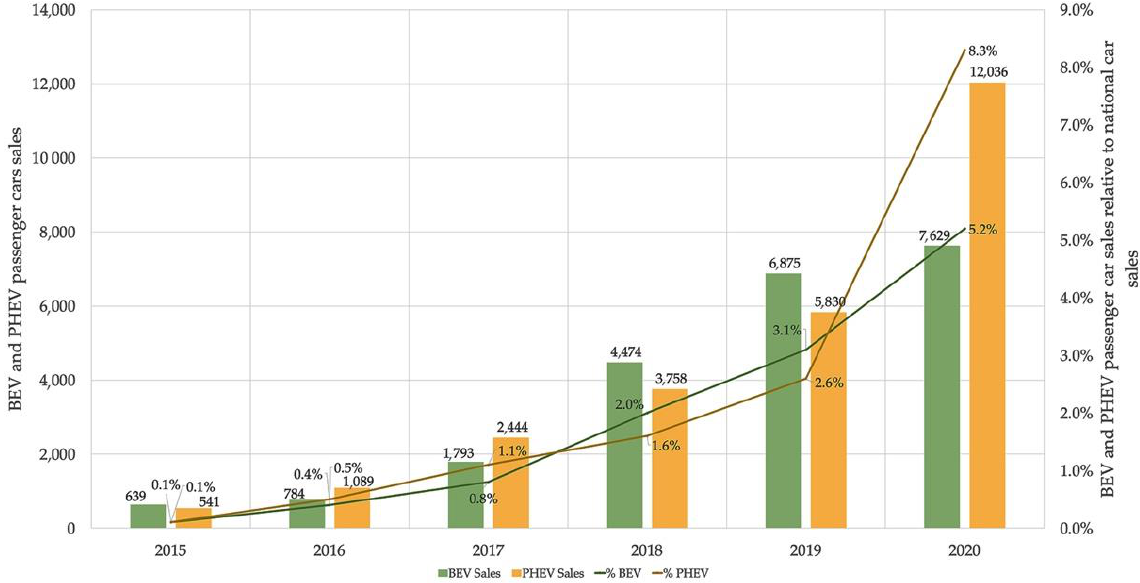
Figure 1. BEV and PHEV passenger car fleet and percentage of the total fleet, 2015 – 2020. Adapted from [37].